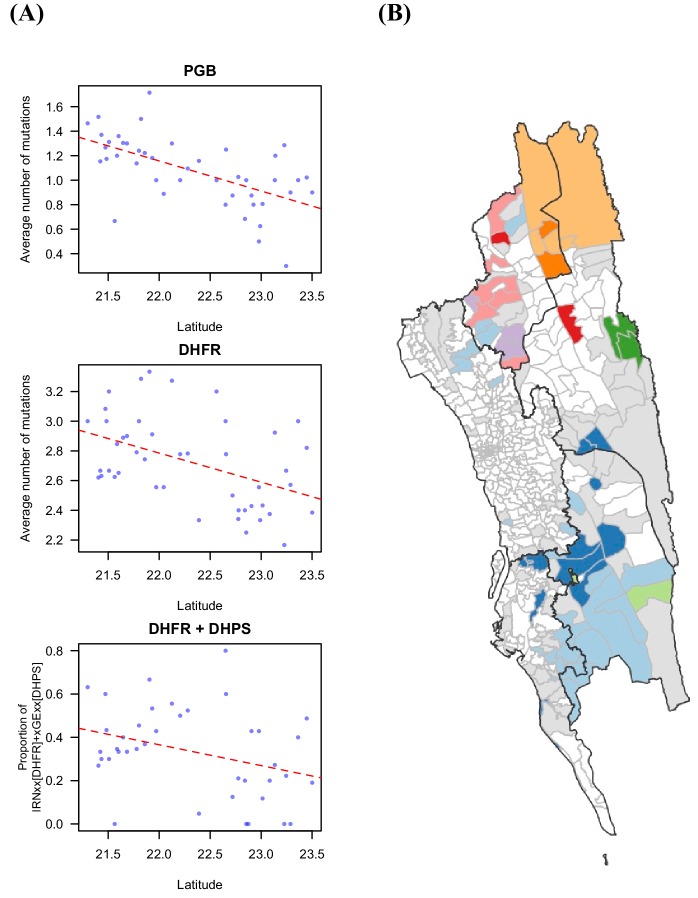
Drug resistant markers and the proportion of identical parasites showing spatial signal.(A) The drug resistance-related markers were significantly associated with latitude, including PGB mutations that were found in genetic background of K13 mutations that lead to artemisinin resistance (Pearson’s correlation test, p-value=1.58 × 10–5, r=–0.601), DHFR mutations that mediated pyrimethamine resistance (Pearson’s correlation test, p-value=0.0018, r=–0.453), and the proportion of the haplotype of IRNxx [DHFR] and xGExx [DHPS], which was shown to be associated with treatment failure for the combination of pyrimethamine and sulfadoxine (Pearson’s correlation test, p-value=0.035, r=–0.335). Red dotted line is the fitted linear regression line. (B) The unions were clustered based on genetic information, the proportion of identical parasites between locations, using Infomap (Rosvall and Bergstrom, 2011). Unions without genetic data are shown in white; unions that had genetic data but did not cluster with any other union are shown in grey; the remaining colors represent the identified cluster (i.e. unions in the same cluster were colored using the same color).